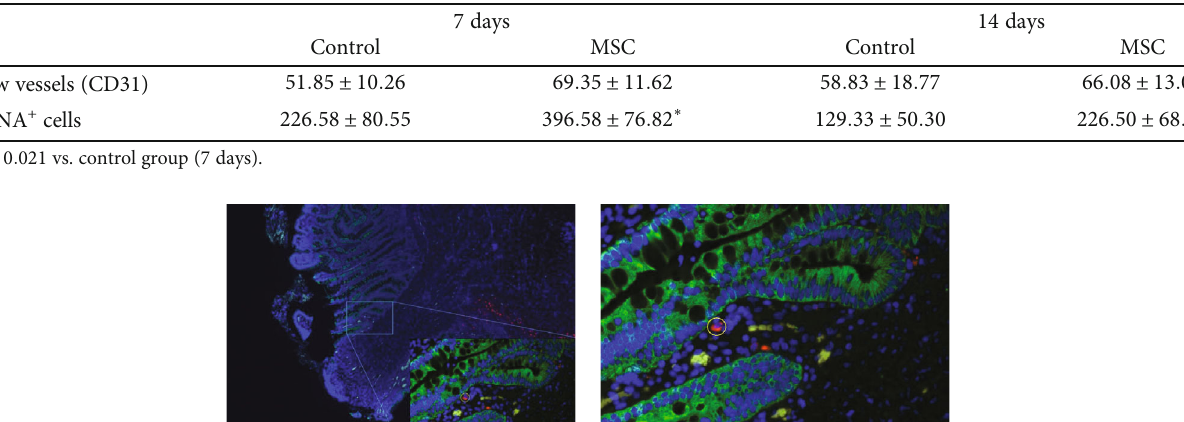
Table 2: IHC staining of the anastomosis junction ( mean ± SD ).